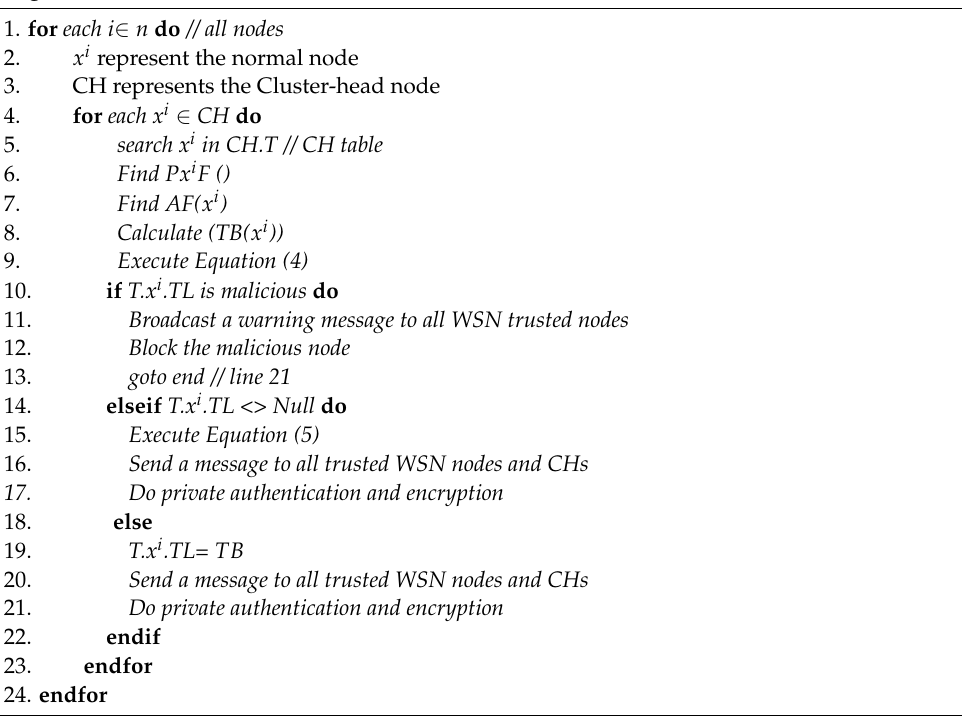
Algorithm 1: The WSN trust-based